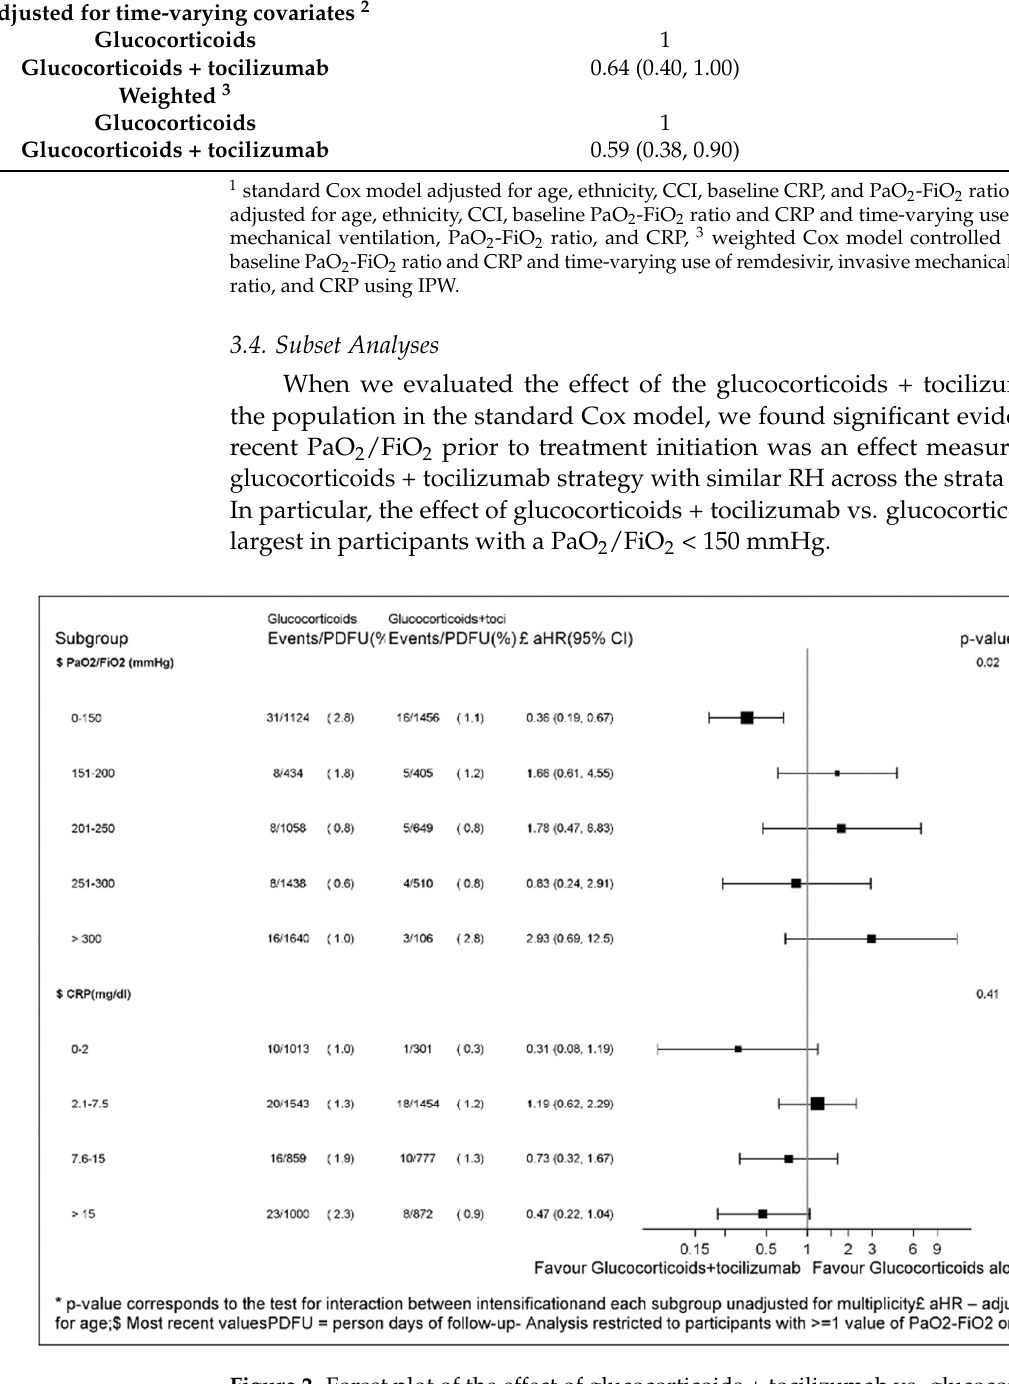
Figure 2. Forest plot of the effect of glucocorticoids + tocilizumab vs. glucocorticoids alone across baseline PaO2/FiO2 and CRP strata.